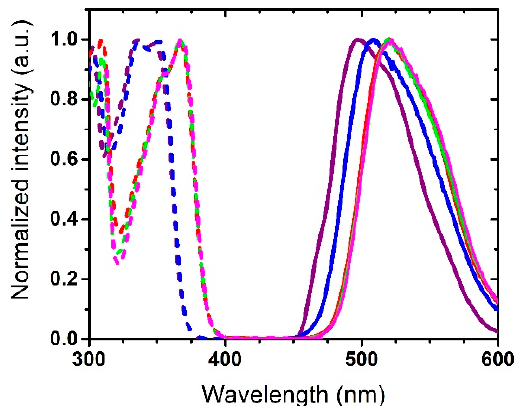
Figure 6. Excitation (dotted line) and emission (plain lines) spectra of HBO dyes 1 (purple), 2 (blue), 3 (red), 4 (green), and 5 (pink) in the solid-state as doped at 1% in PMMA films.